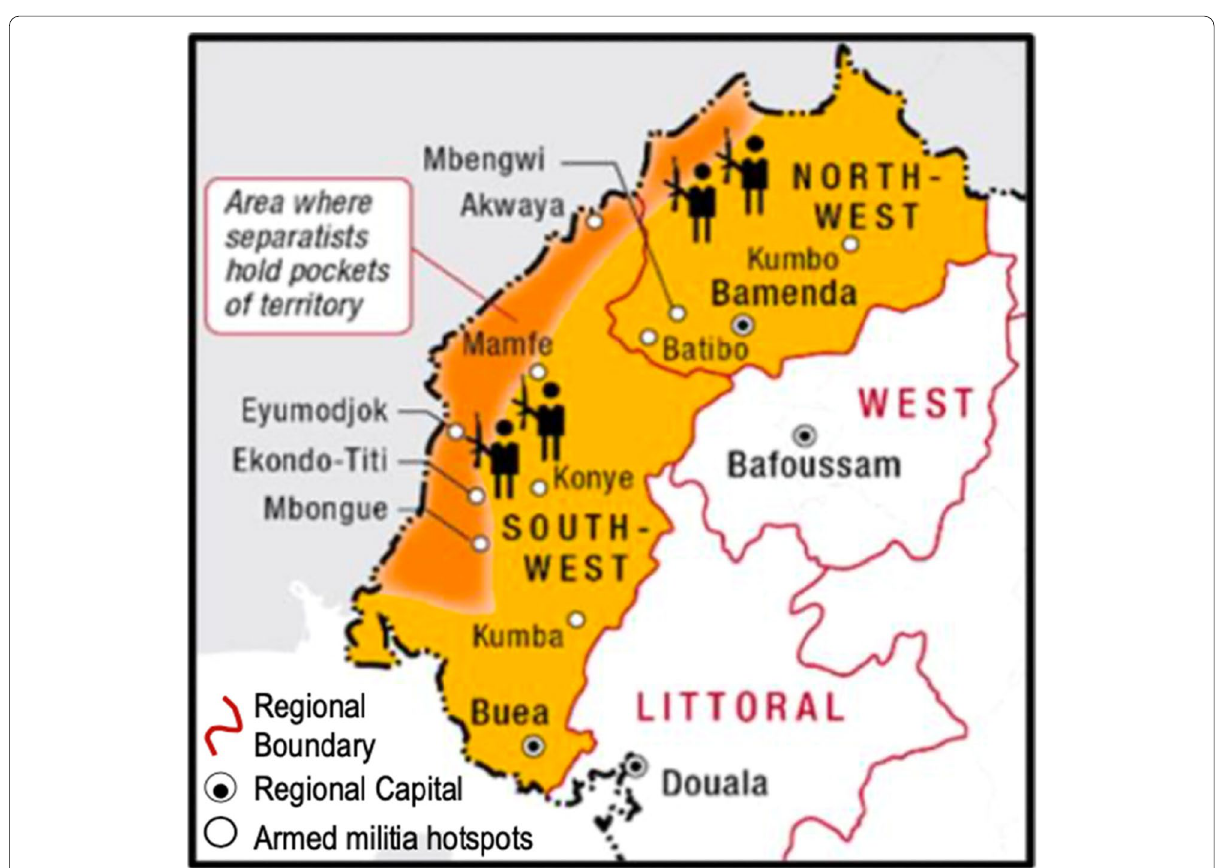
Fig. 2 Map of the Anglophone region showing pockets of territory allegedly controlled by the separatists. Source: adapted from the ICG